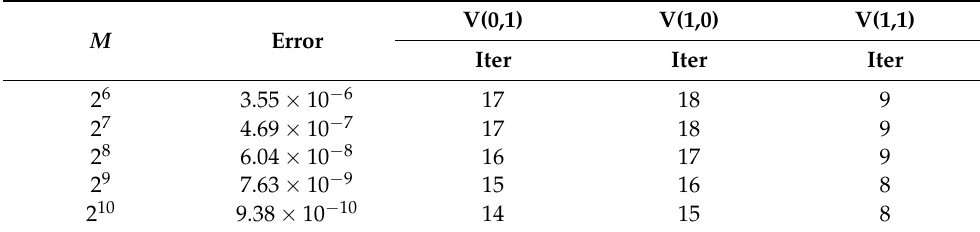
Table 8. L 2 errors for (84) with ω = 0.5, by the third-order scheme. M